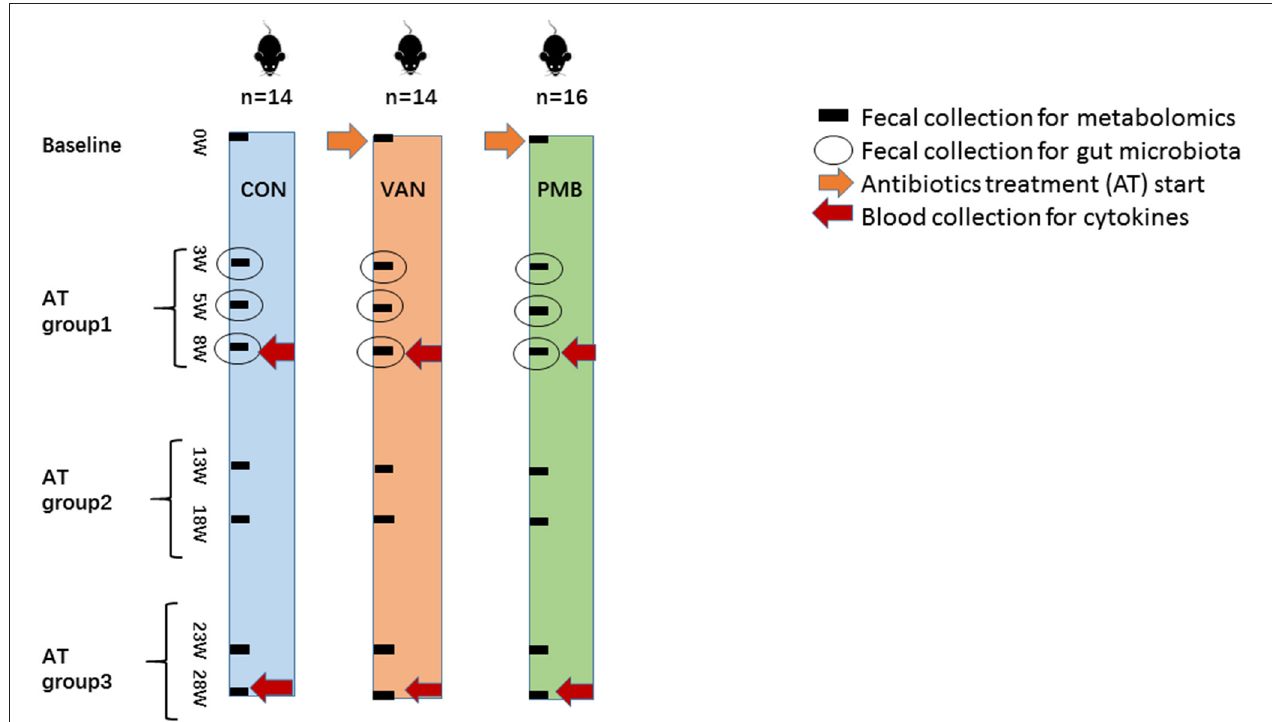
FIGURE 1 | Scheme of the study design. A total of three groups of 3-week-old female C57BL/6 mice ( n = 44) were continuously treated with vancomycin (VAN, n = 14), polymyxin B (PMB, n = 16), or water (CON, n = 14), respectively, for up to 28 weeks. The fecal samples before and after treatment for 3, 5, 8, 13, 18, 23, 28 weeks were used for metabolomic analysis. The fecal samples collected at 3-, 5-, and 8-week treatment were examined by 16S rRNA gene sequencing. Blood was collected after 8- and 28-week treatment for the determination of serum cytokines. Antibiotic treatment (AT) groups 1, 2, and 3 referred to the timing of treatment for 3, 5, and 8weeks, for 13 and 18 weeks, and for 23 and 28 weeks, respectively. AT, antibiotic treatment; VAN, vancomycin; PMB, polymyxin B; CON,